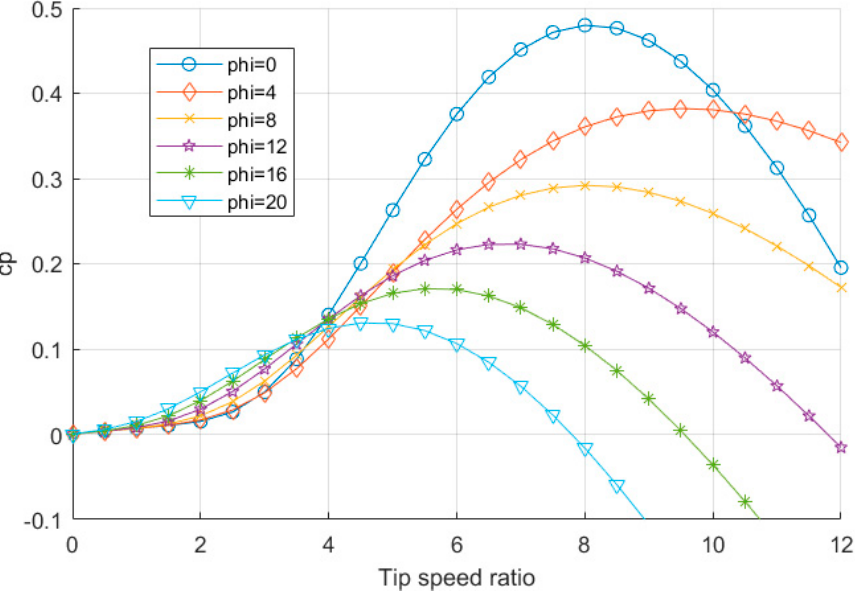
Figure 2. Power coefficient ( C (cid:2900) ) vs. tip speed ratio ( λ ) for different pitch angles ( ϕ ). Figure 2. Power coe ffi cient (C P ) vs. tip speed ratio ( λ ) for di ff erent pitch angles ( φ